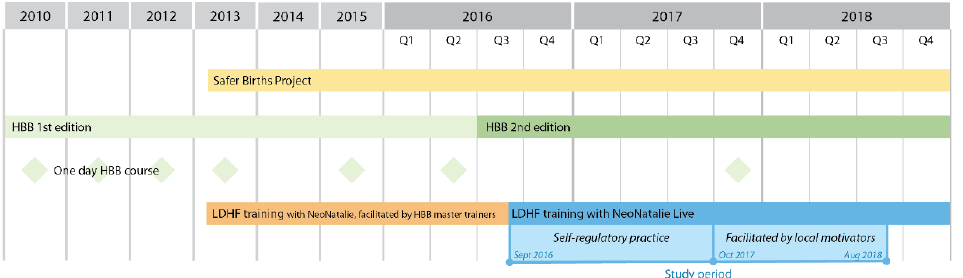
Figure 1. Simulation-based training at Haydom Lutheran Hospital 2010–2018. HBB; Helping Babies Breathe, LDHF; low-dose high frequency training. “Local motivators” were dedicated midwives tasked to facilitate and motivate for on-site LDHF training, following the HBB Second Edition.